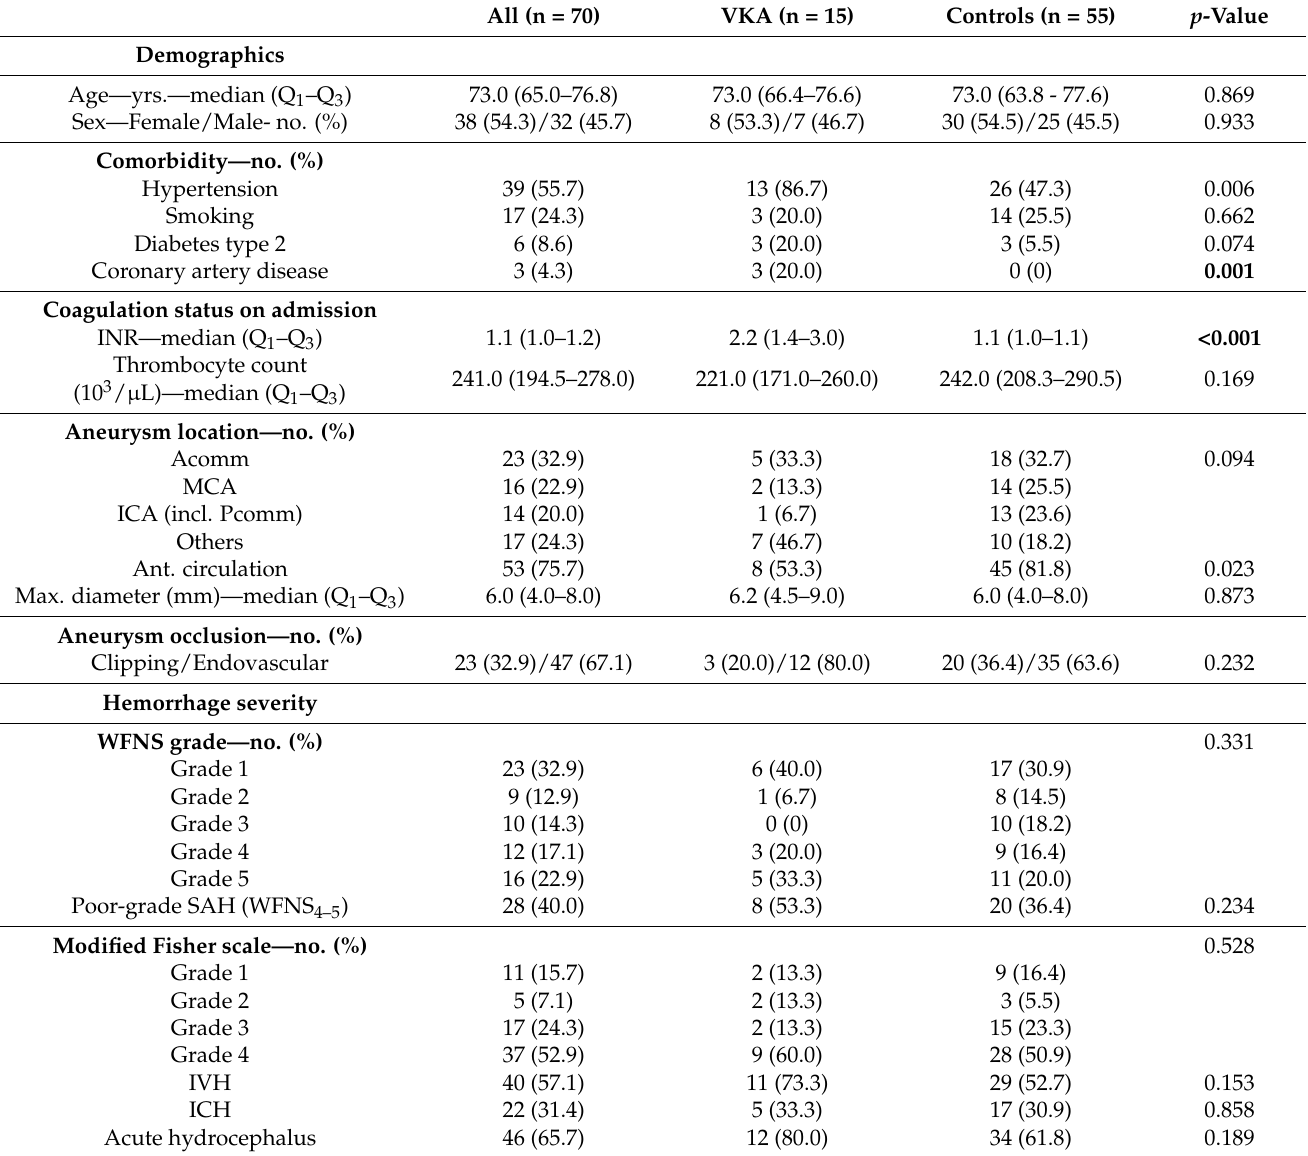
Table 2. Comparison of patients on vitamin K antagonists (VKA) with age- and sex-matched controls without antithrombotic treatment. All (n = 70) VKA (n = 15) Controls (n = 55) p